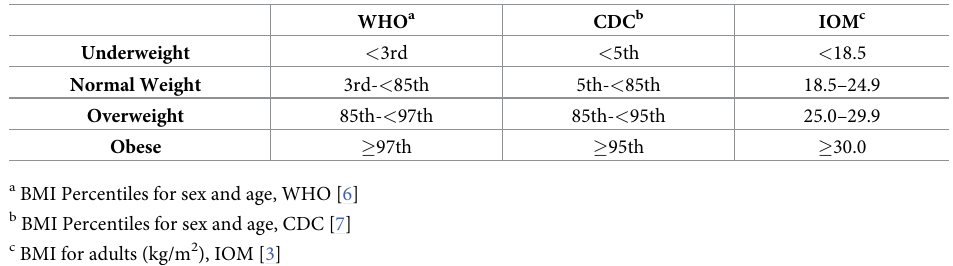
Table 1. Body mass index categories according to three different